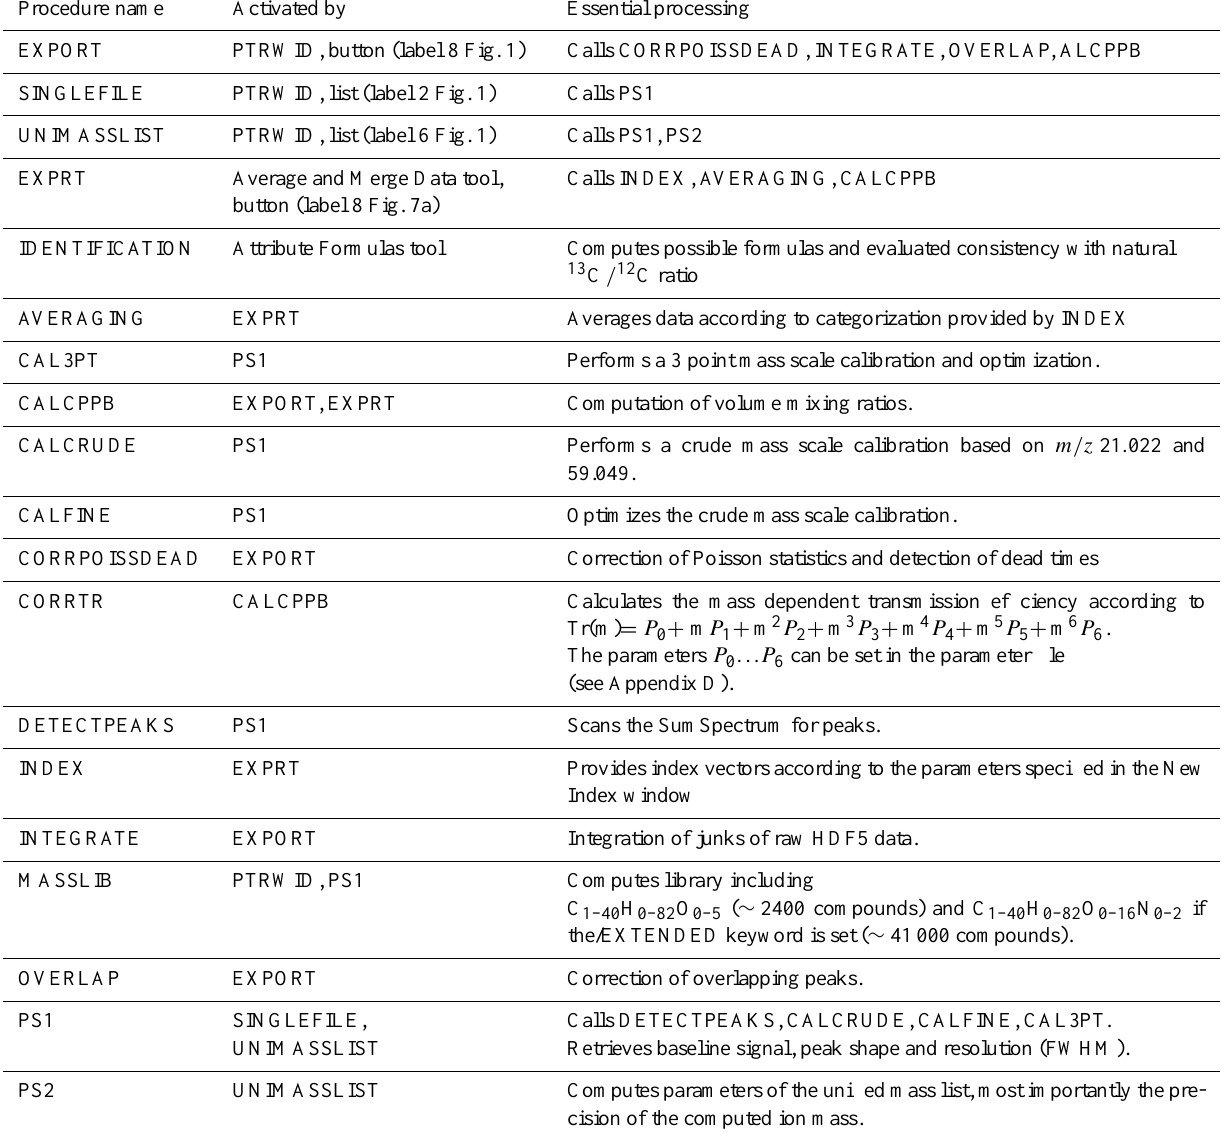
Table B1. Key routines used by